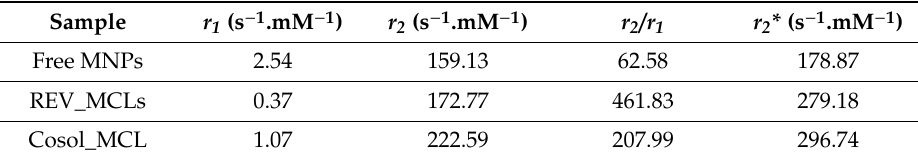
Figure 14. T2 weighted MRI at 7 T of: ( A ) free MNPs; ( B ) REV_MCLs; and ( C ) cosol_MCLs at various iron concentrations in water. Table 5. Calculated relaxivities of free MNPs, REV_MCLs, and cosol_MCLs at various concentrations of iron in water at 7